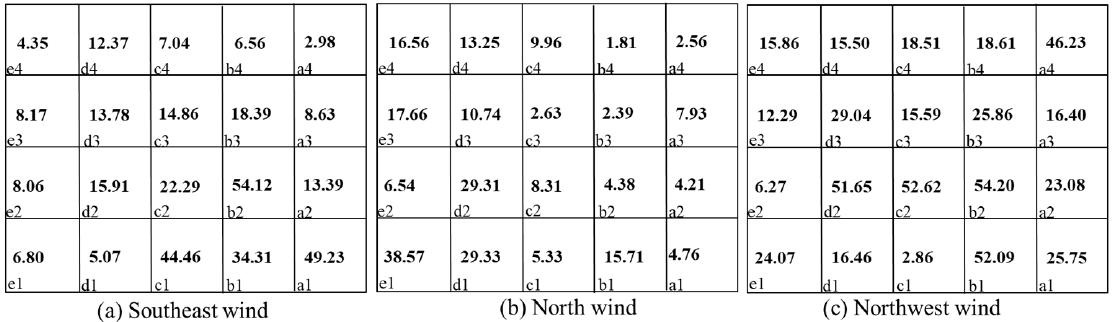
Figure 11. Ventilation rates of rooms ACH (h − 1 ) in Q1. a1,2,3,4-e1,2,3,4 represent the number of dormitory room.